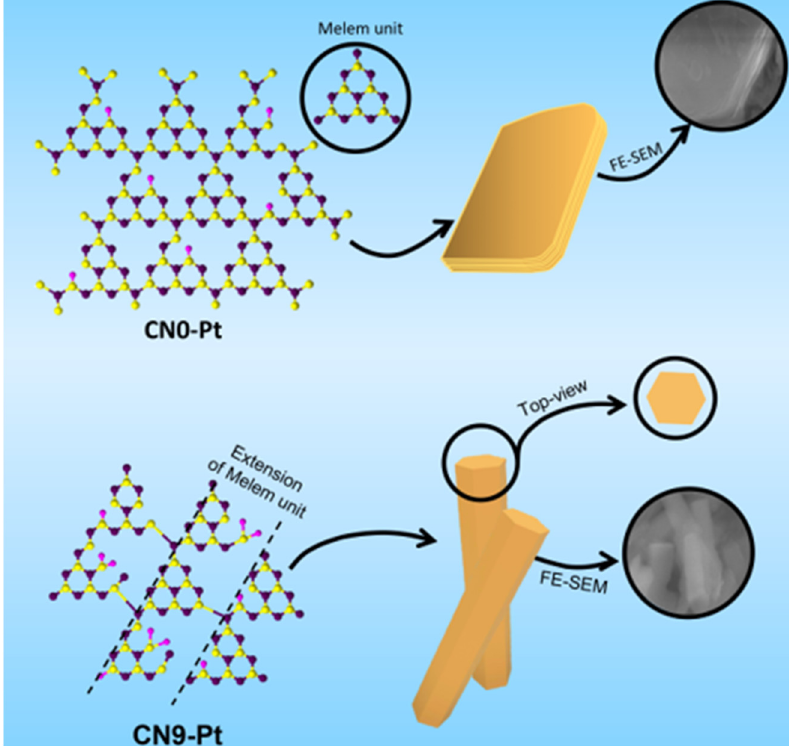
Figure 7. A schematic diagram for physicochemical and morphological modifications of CNx ‐ Pt.